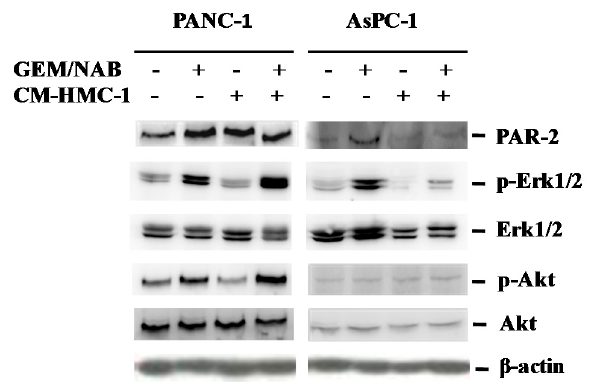
Figure 4. Signalling cascade activated in response to CM-HMC-1 in GEM/NAB treated and untreated cells. PAR-2 expression was increased by GEM/NAB in the responsive cells (AsPC-1) but not when CM-HMC-1 was added; instead in the resistant PANC-1 cells, both GEM/NAB and CM-HMC-1 increased PAR-2 expression. Accordingly, the activation of PAR-2 downstream effector Erk1/2 was found on AsPC-1 after GEM/NAB and on PANC-1 after GEM/NAB and CM-HMC-1, together with the activation of Akt.